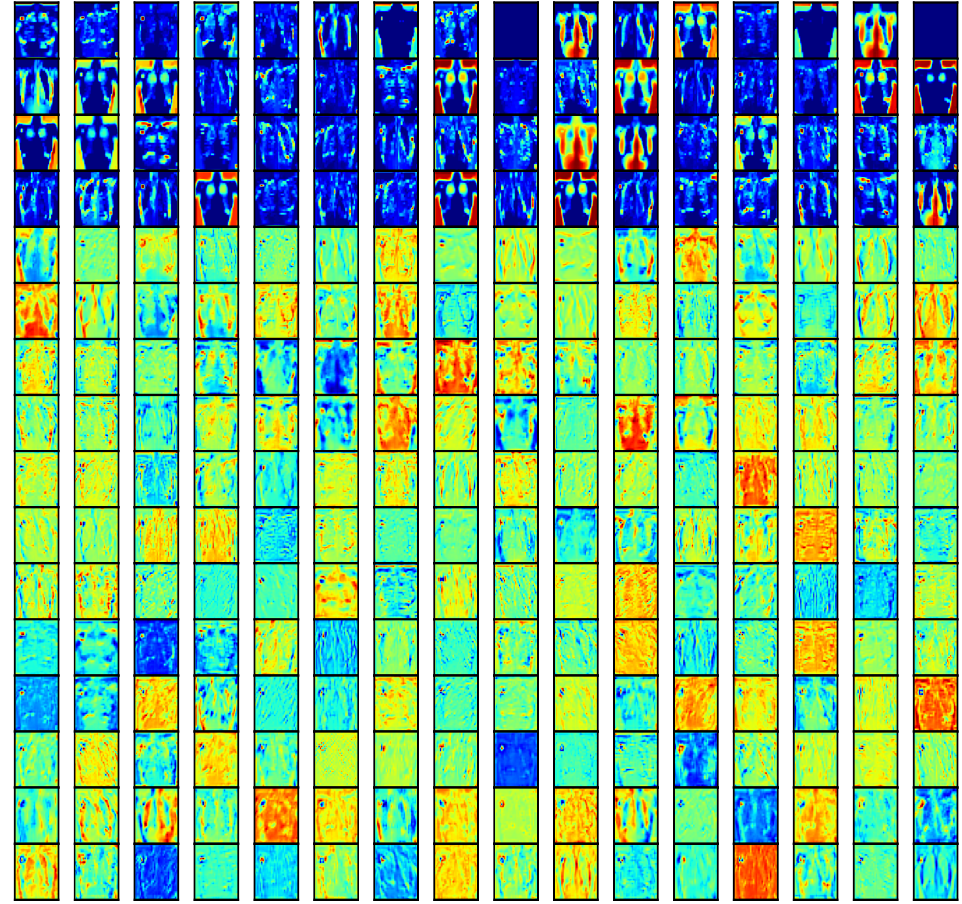
Figure 21. In this diagram (ResNet-50 convolution layer 48 with 256 filter activation maps in a 16 × 16 grid), we see the emergence of XCR image structure in the feature maps after Transfer Learning. This shows that the representation of the network has learnt inherent invariant regularities in the XCR